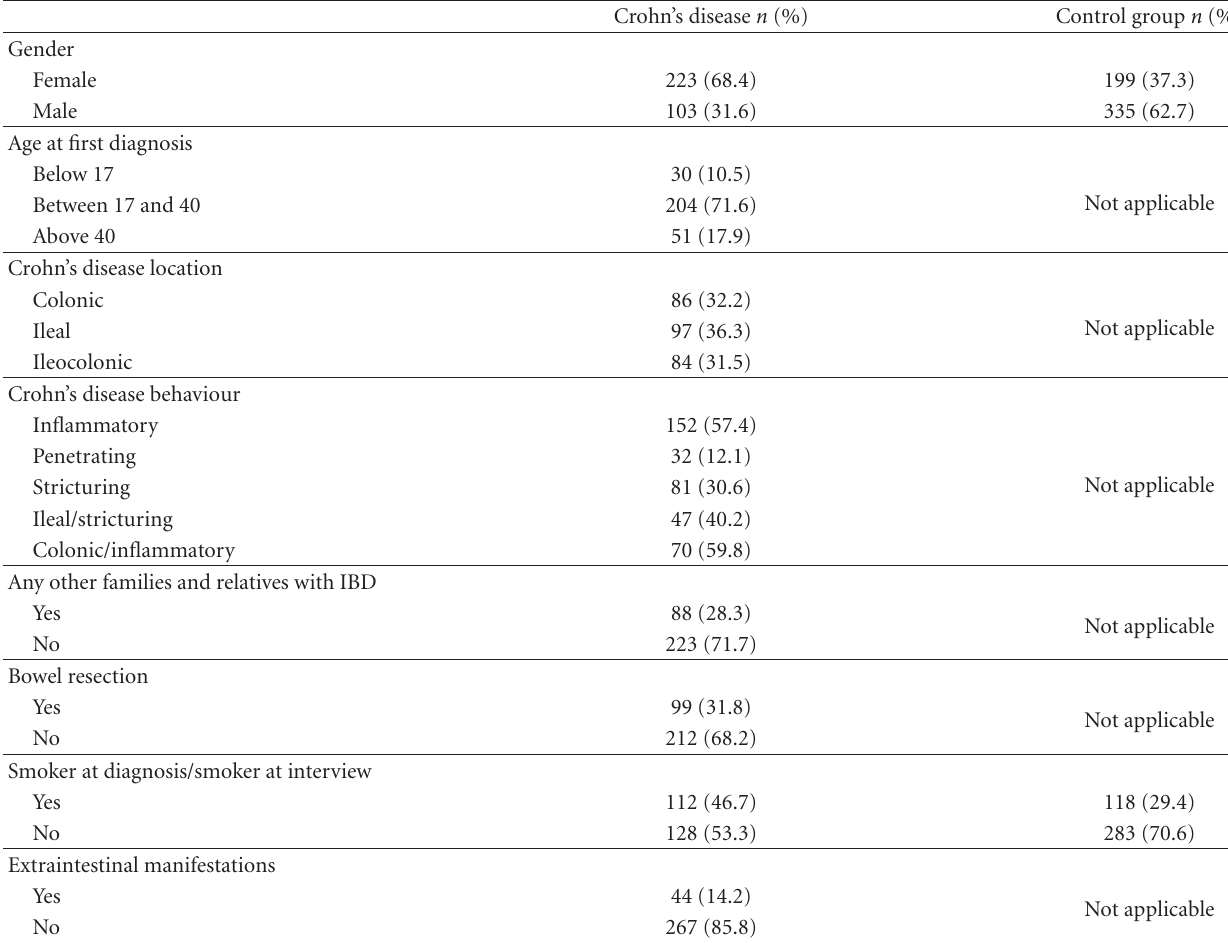
Table 1: Summary of Crohn’s disease and controls and Montreal classification